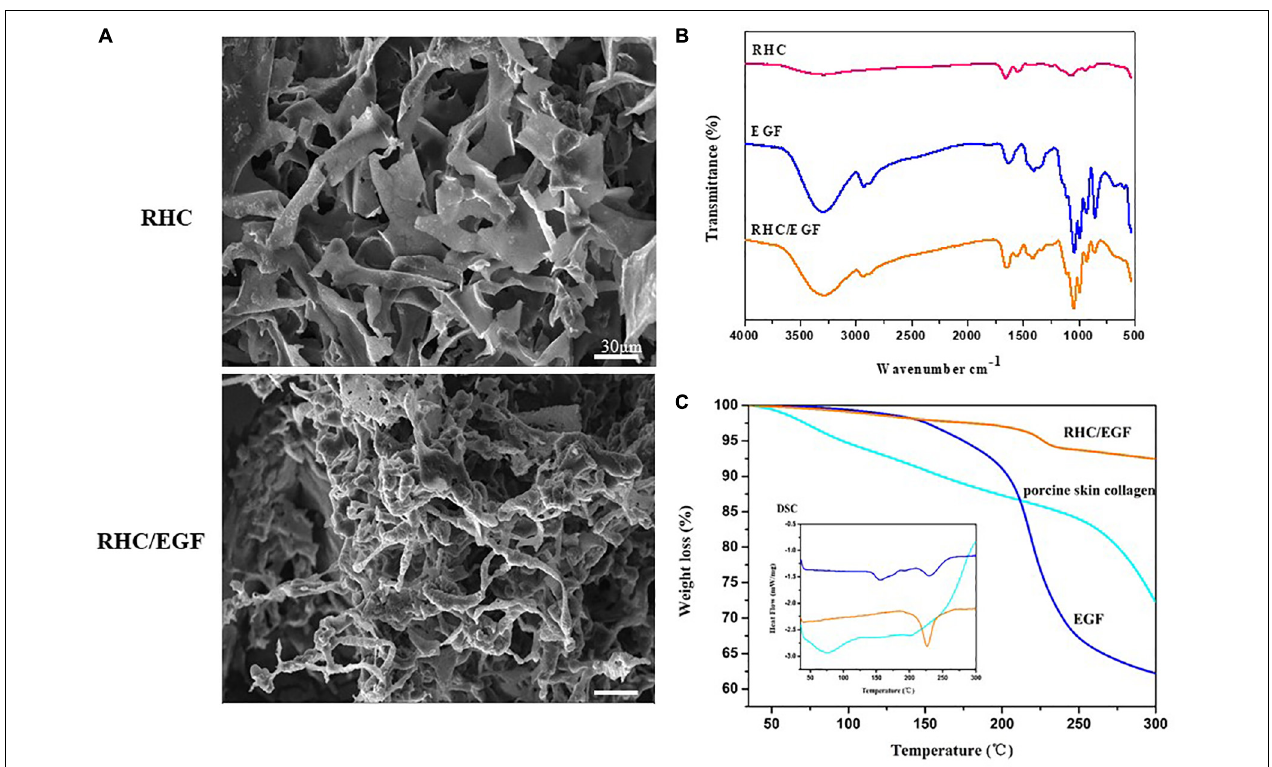
FIGURE 3 | Characteristics of RHC and RHC/EGF. (A) Scanning electron micrographs of RHC and RHC/EGF freeze-dried dressings. (B) Fourier transform infrared spectra of RHC, EGF, and RHC/EGF freeze-dried dressings. (C) Differential scanning calorimetry spectrum of EGF, porcine skin collagen, RHC/EGF freeze-dried